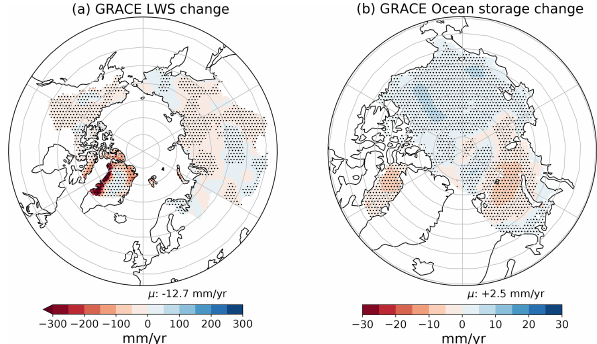
Figure A1. 2002–2019 land water storage trends (left, areal mean of − 12 . 7mmyr − 1 ) and oceanic storage trends (right, areal mean of + 2 . 5mmyr − 1 ), calculated as the mean of GRACE JPL, CSR, and GSFC Mascons. Shading denotes significant trends ( p val- ues <